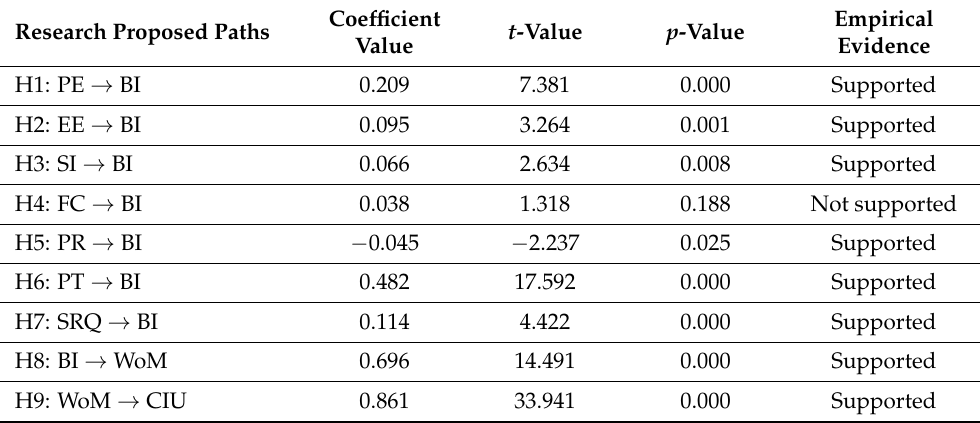
Table 7. Summary of proposed results for the theoretical model. Research Proposed